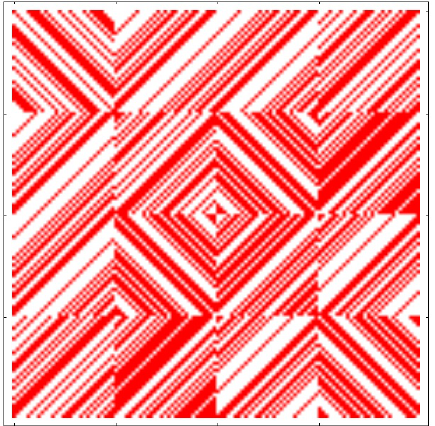
Figure 2: A visualization of the first solution of order 4 · 29 =